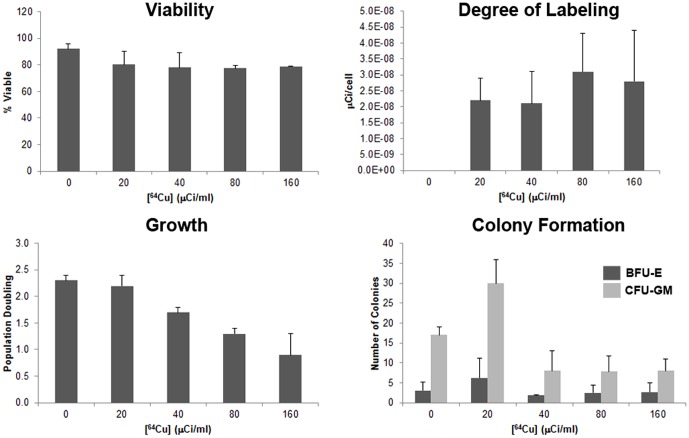

64Cu-TETA-CD45 radiolabeling of hPBSC.hPBSC were radiolabeled with 0, 20, 40, 80, or 160 µCi/mL of 64Cu-TETA-CD45. No significant changes in cell viability or degree of labeling were observed with increasing concentrations. A decline in cell growth and colony formation was observed when cells were incubated with 64Cu-TETA-CD45 at a concentration >20 µCi/mL.